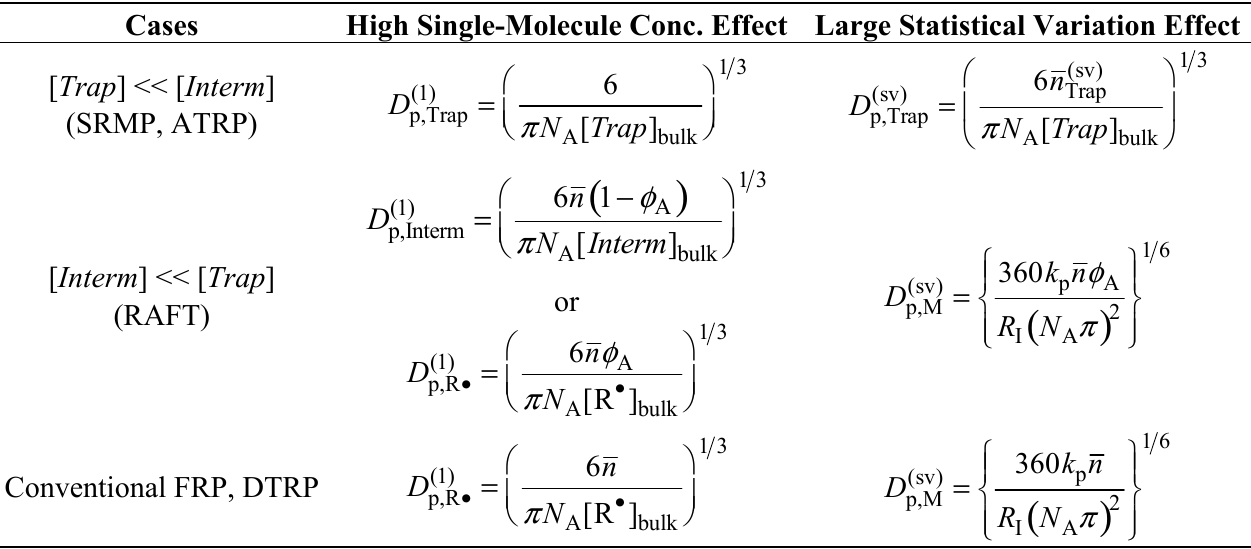
Table 4. Obtained threshold particle diameters for various RDRPs and conventional